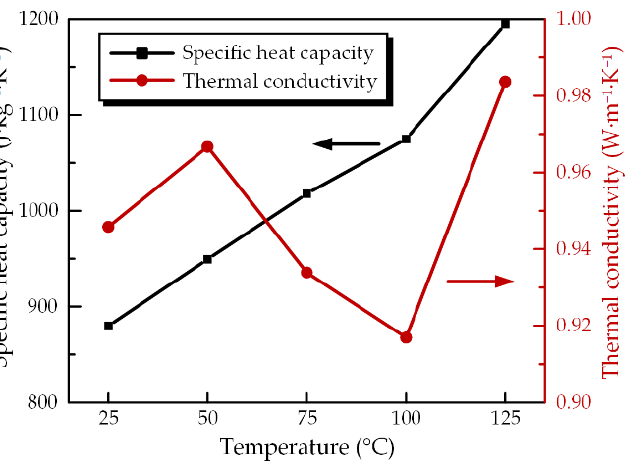
(NETZSCH, DSC 200F3). The results are shown in Figure 2.